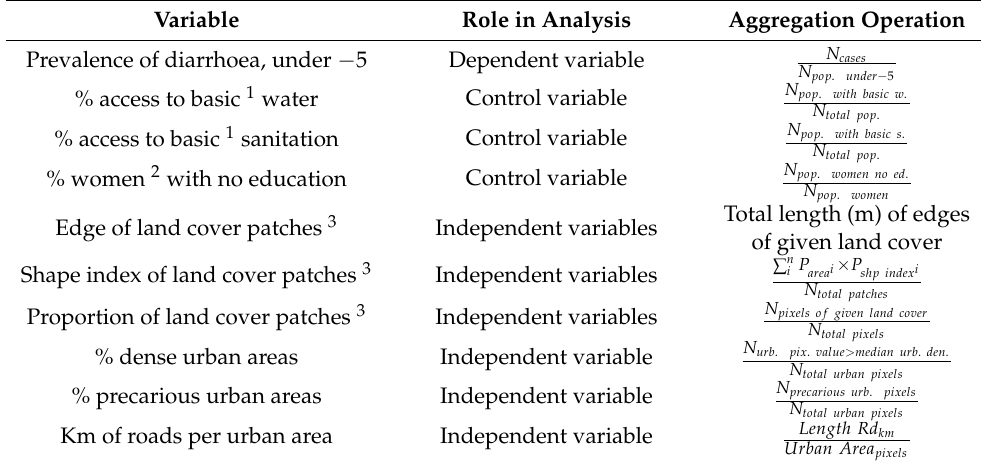
Table 2. List of variables calculated for each spatial unit (variables aggregated by buffer